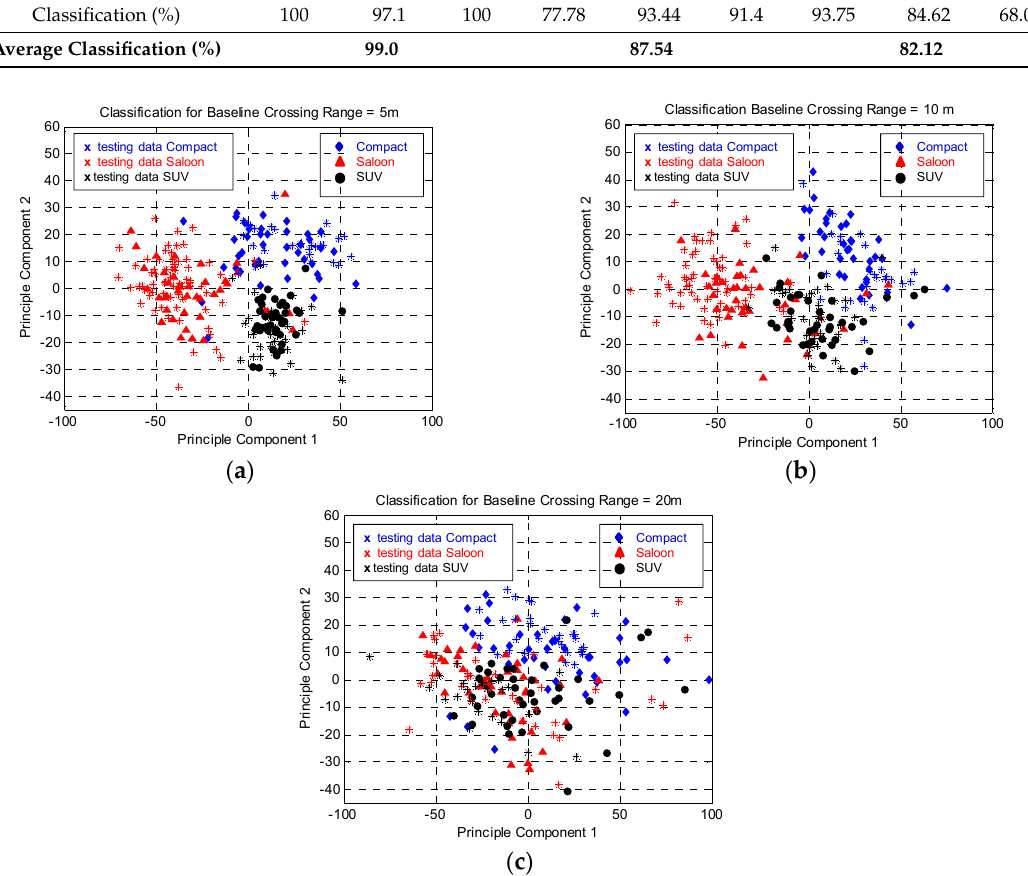
Figure 13. Location of training and testing data for all vehicle categories at different R R in PCA space for ( a ) R = 5 m; ( b ) R = 10 m and ( c ) R = 20 m.